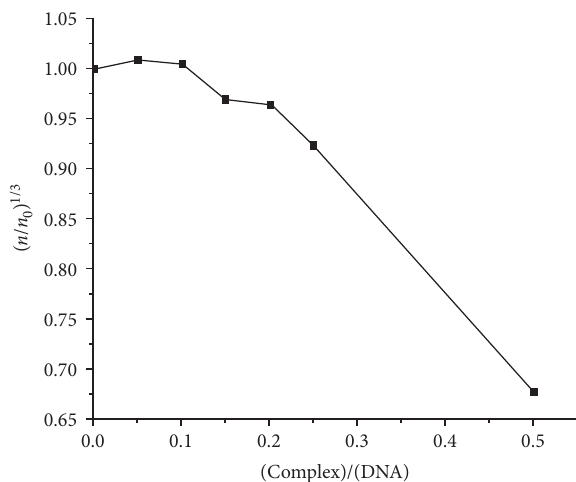
Figure 6: Relative viscosity of DNA versus DNA/complex 2